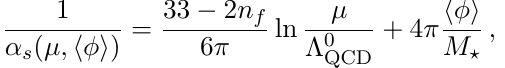
, but transitioning to SM-like behavior for lower tempera- d